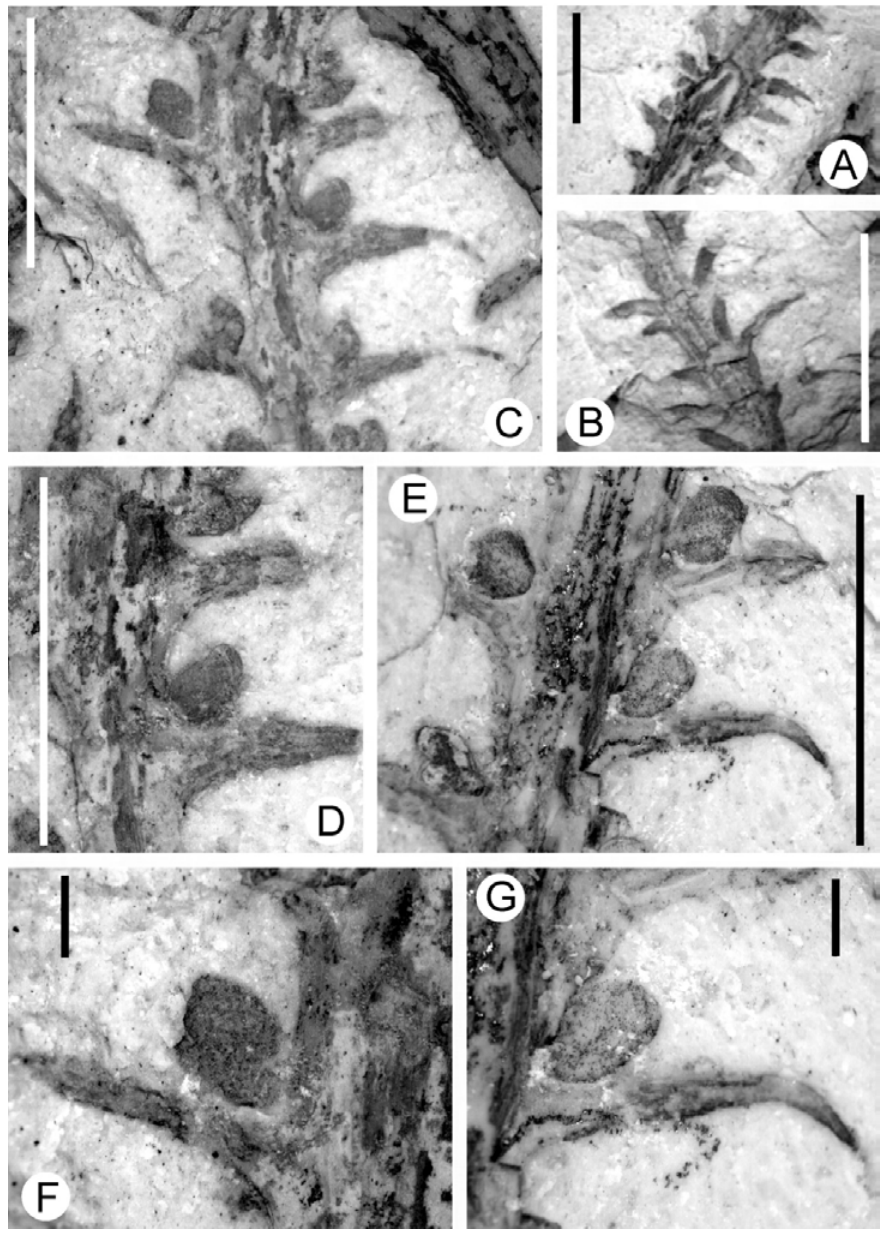
Fig. 3 – Lycopodites riograndensis : A) General view of the availed material (PbU 038 – graphic scale corresponding to 10.0 mm); B) Detail of the round form microphylls from the basal to the apical portion (PbU 262 – graphic scale corresponding to 10.0 mm); C) Detail of the basal round form and the apical sharp form of the microphyles (PbU 190 – graphic scale corresponding to 5.0 mm); D) Detail of the Fig. 3C with the distribution of sporangia at the right side (graphic scale corresponding to 5.0 mm); E) Detail of helicoidal distribution of the microphylls at the stem with attached sporangia (PbU 190 – graphic scale corresponding to 5.0 mm); F) Detail of Fig. 3C demonstrating a sporangia at the left side (PbU 190 – graphic scale corresponding to 1.0 mm); G) Detail of Fig. 3E demonstrating a sporangia at the right side (PbU 190 – graphic scale corresponding to 1.0